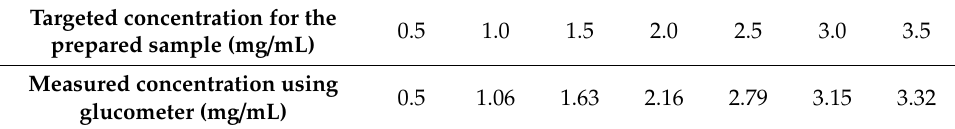
Table 3. Concentration verification of the prepared synthetic blood samples using a glucometer